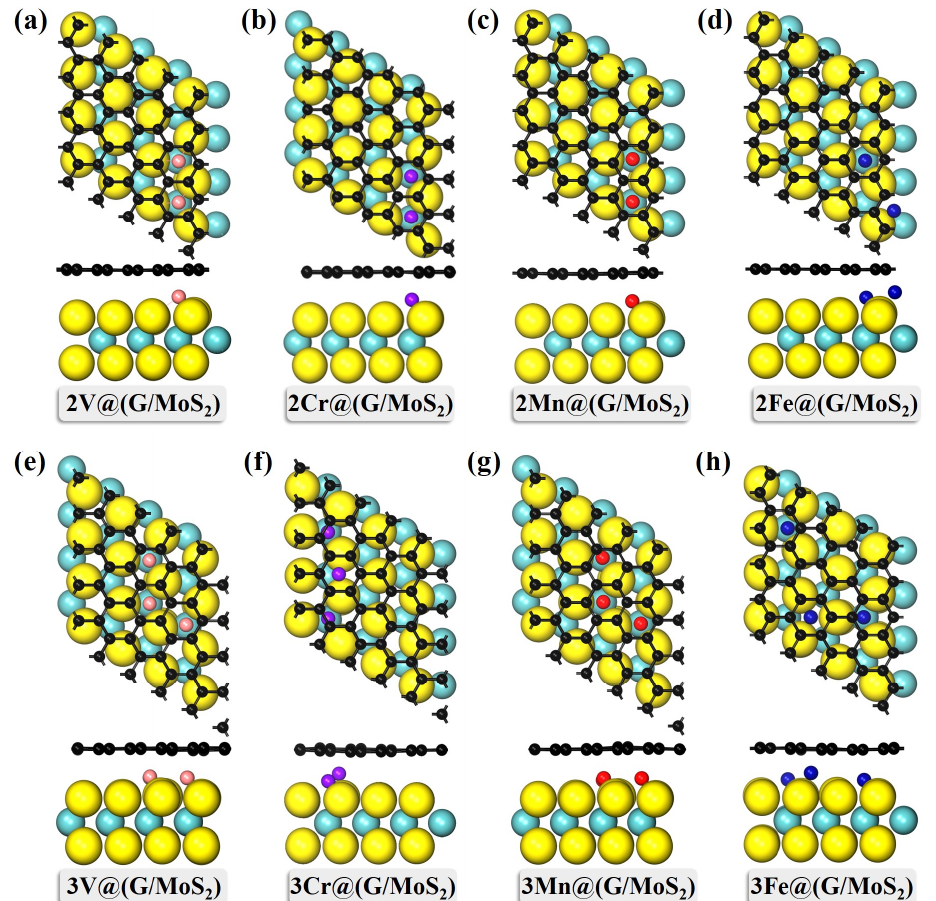
Figure 3. The lowest energy structures of ( a – d ) 2TM@(G/MoS 2 ) and ( e – h ) 3TM@(G/MoS 2 ) (TM = Ti, V, Cr, Mn).